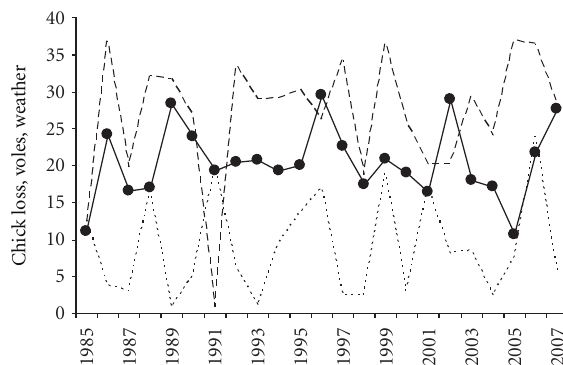
Figure 4: Kill rate by goshawks ( ◦ ) and losses of black grouse chicks ( • ) in South Ostrobothnia and Oulu area during 1985–2007. Time series of the two study areas are separated by dotted line.